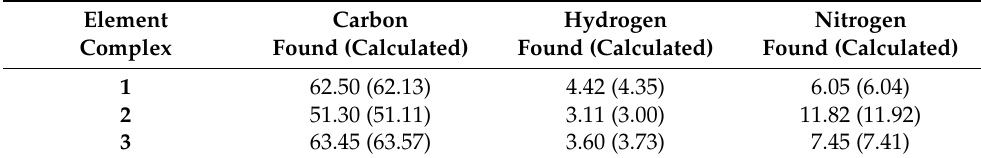
Table 1. Elemental analysis of 1, 2 and 3 .